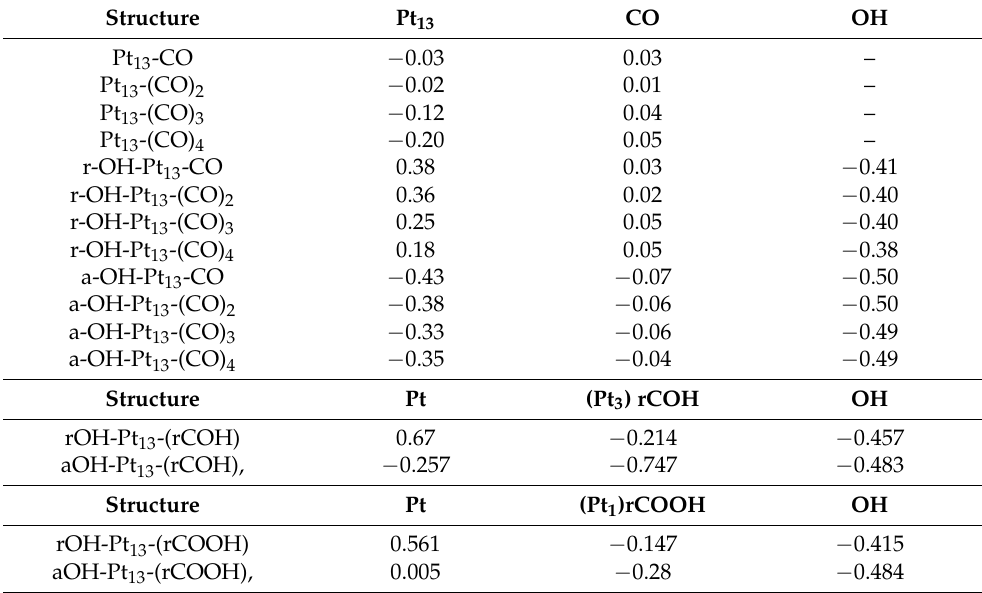
Table 2. Natural charges in systems Pt 13 (CO) n , rOH-Pt 13 -(CO) n and aOH-Pt 13 -(CO) n , rOH-Pt 13